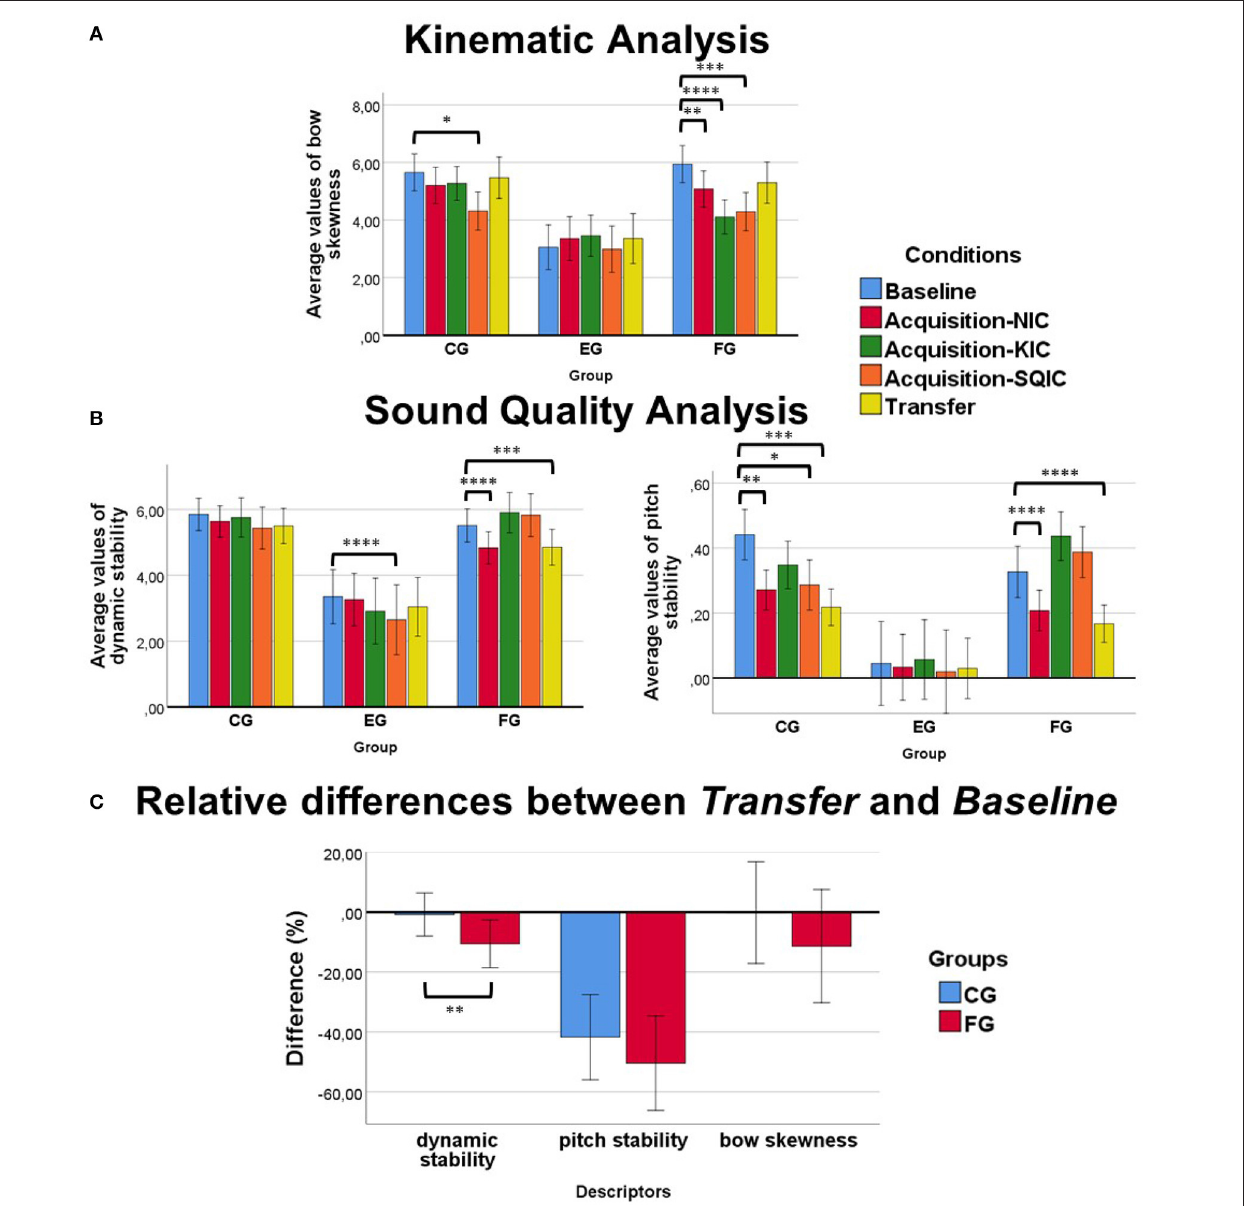
FIGURE 5 | (A) Kinematic analysis. Bow skewness results: the FG improved significantly their results compared with the Baseline at the moment of receiving online feedback on bow motion (i.e., at the Acquisition-KIC ) and in the rest of the conditions from the Acquisition phase. The CG improved their results only at the Acquisition-SQIC . (B) Sound Quality Analysis. dynamic stability results (left): although results for the FG tended to get worse at the moment of receiving online feedback, those results were transferred to conditions without feedback ( Acquisition-NIC and Transfer ). No significant improvements were found for the CG. pitch stability results (right): both groups of beginners (control and feedback) improved their results in pitch stability at the Acquisition-NIC and Transfer . The FG tended to get worse results when receiving online feedback. (C) Relative differences between Baseline and Transfer : The FG seemed to improve, on average, more than the CG in all the descriptors. However, only significant results between groups were found at dynamic stability . * p ≤ 0.05, ** p ≤ 0.01, *** p ≤ 0.001, **** p ≤